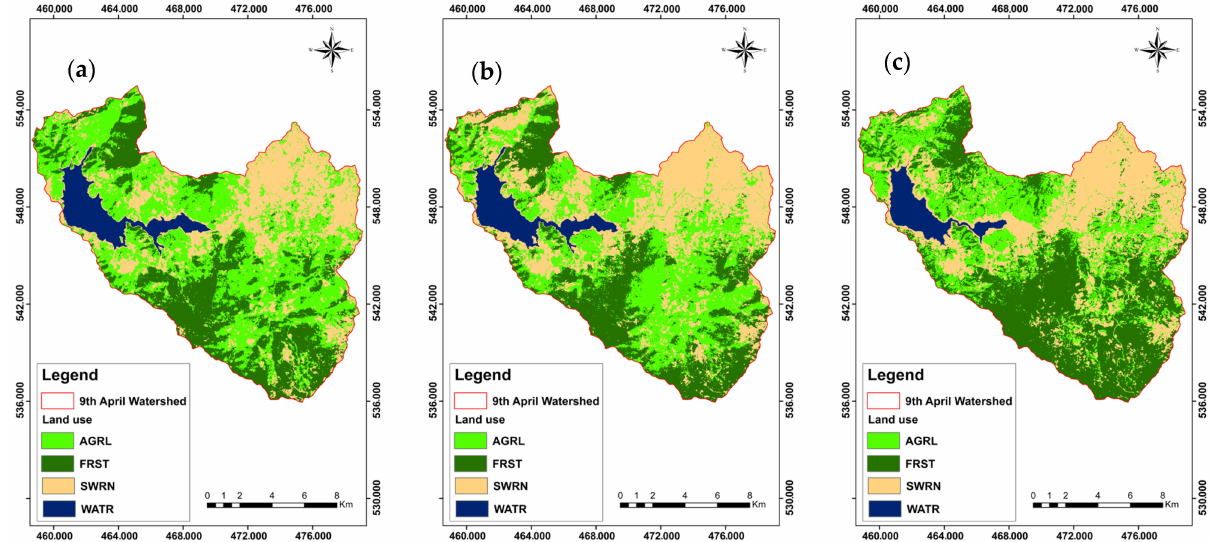
Figure 3. ( a ) Land use of 1998; ( b ) Land use of 2008; ( c ) Land use of 2018.